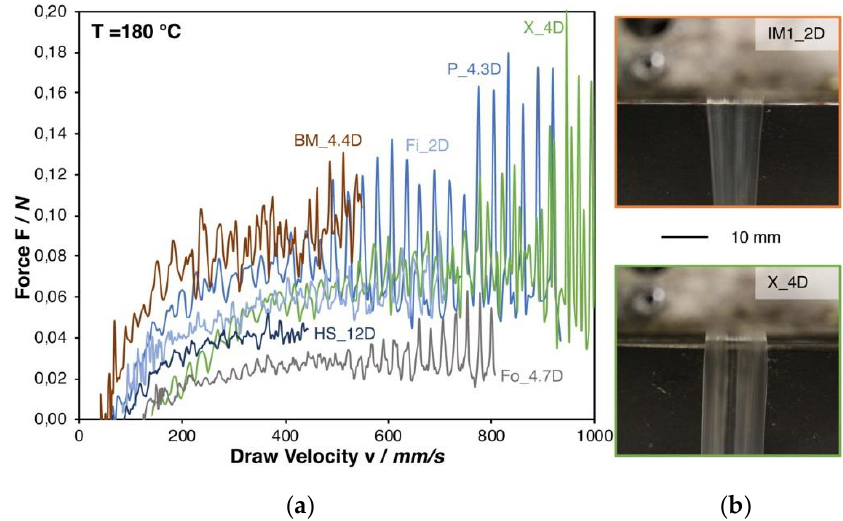
Figure 3. ( a ) Rheotens curves of all (measurable) PLA grades at 180 °C. ( b ) Die swelling behavior of a low and a high molecular PLA.